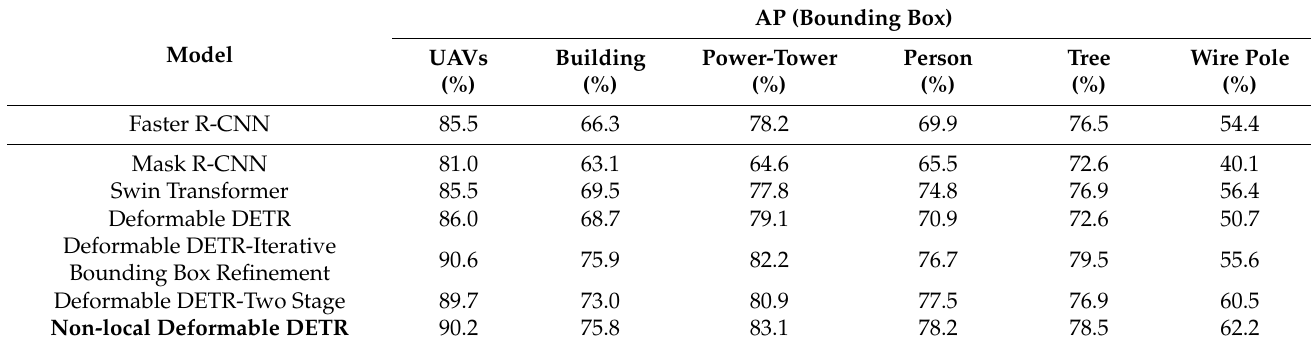
Table 2. Performance comparison of different models in each